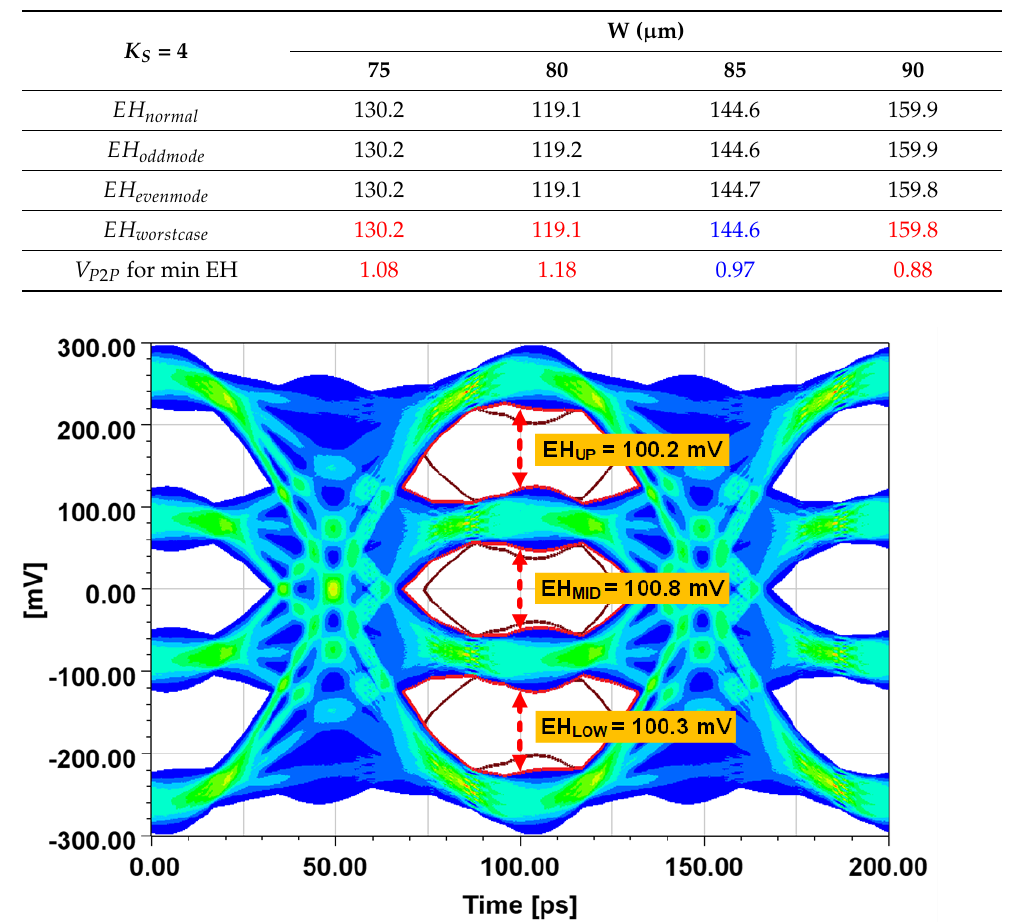
Figure 11. Eye diagram for W = 85 µ m, K S = 4 at V P 2 P = 0.97